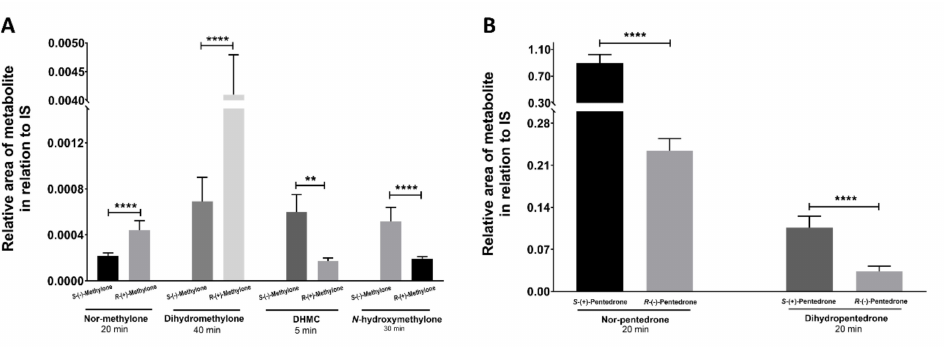
Figure 9. ( A ) Methylone metabolites (nor-methylone, DHMC, N -hydroxymethylone, and dihy- dromethylone) produced in the peak time points after incubation with microsomes (1 mg/mL). ( B ) Pentedrone metabolites (nor-pentedrone and dihydropentedrone) produced in specific time points after incubation with microsomes (1 mg/mL). Data are presented as average ± SD ( n = 2). ** p < 0.01, **** p <